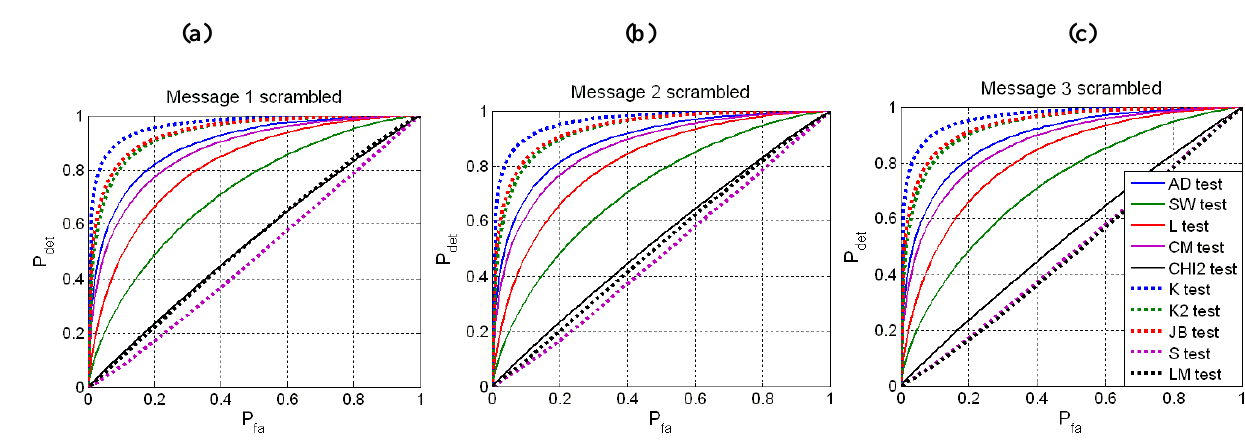
Figure 14. Normality test performance in the detection of a telegraphic interference signal. ROC curves of the different tests are presented in function of 3 different messages scrambled with PRN signal shown in Figure 9, setting the sample size to 16,384 and INR to − 5.2 dB. It can be observed that all ROC curves are almost equal for each interfering signal, deducing that if the telegraphic signal is encrypted or scrambled, it can be treated as a spread spectrum signal. Results obtained from a Monte-Carlo set of 2 15